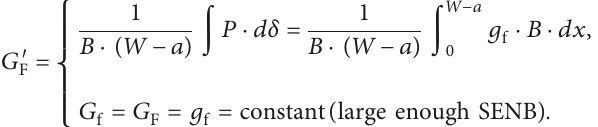
Figure 4: Distribution characteristics of g fractured ligament area.